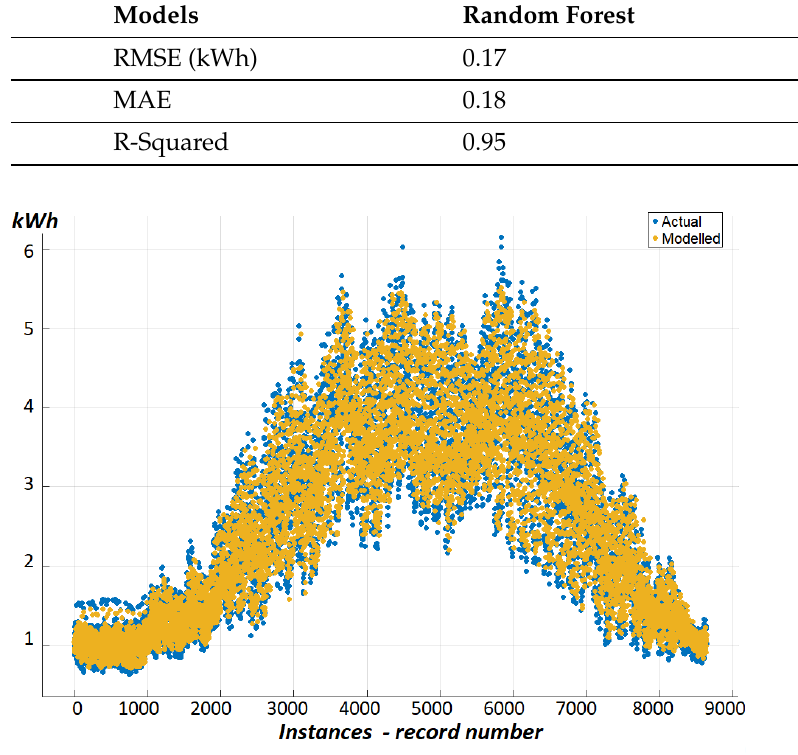
Figure 17. Day-ahead SVR-based forecast models for the ‘AC-included’ category.